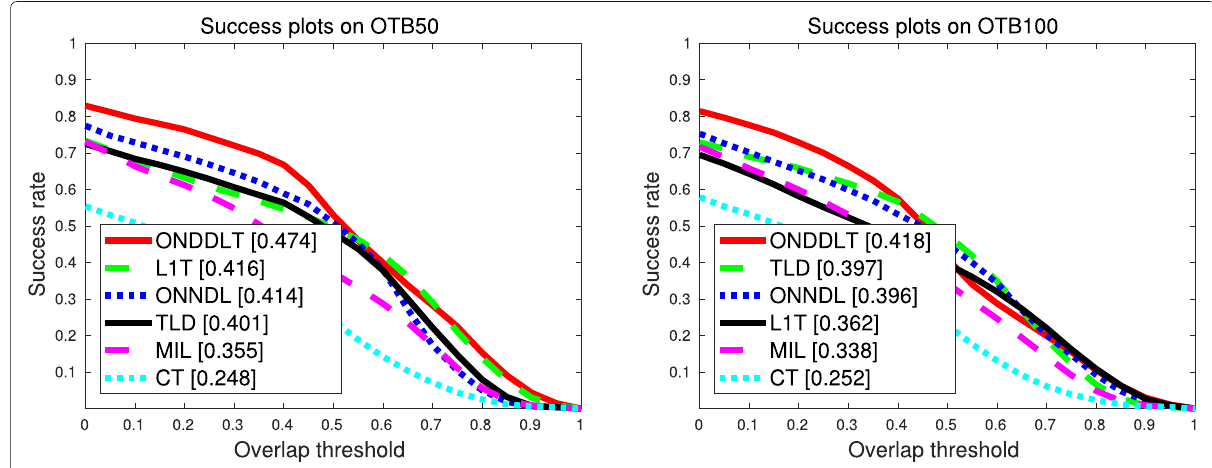
Fig. 1 Success plots compared with the relative trackers on the OTB50 and OTB100 datasets